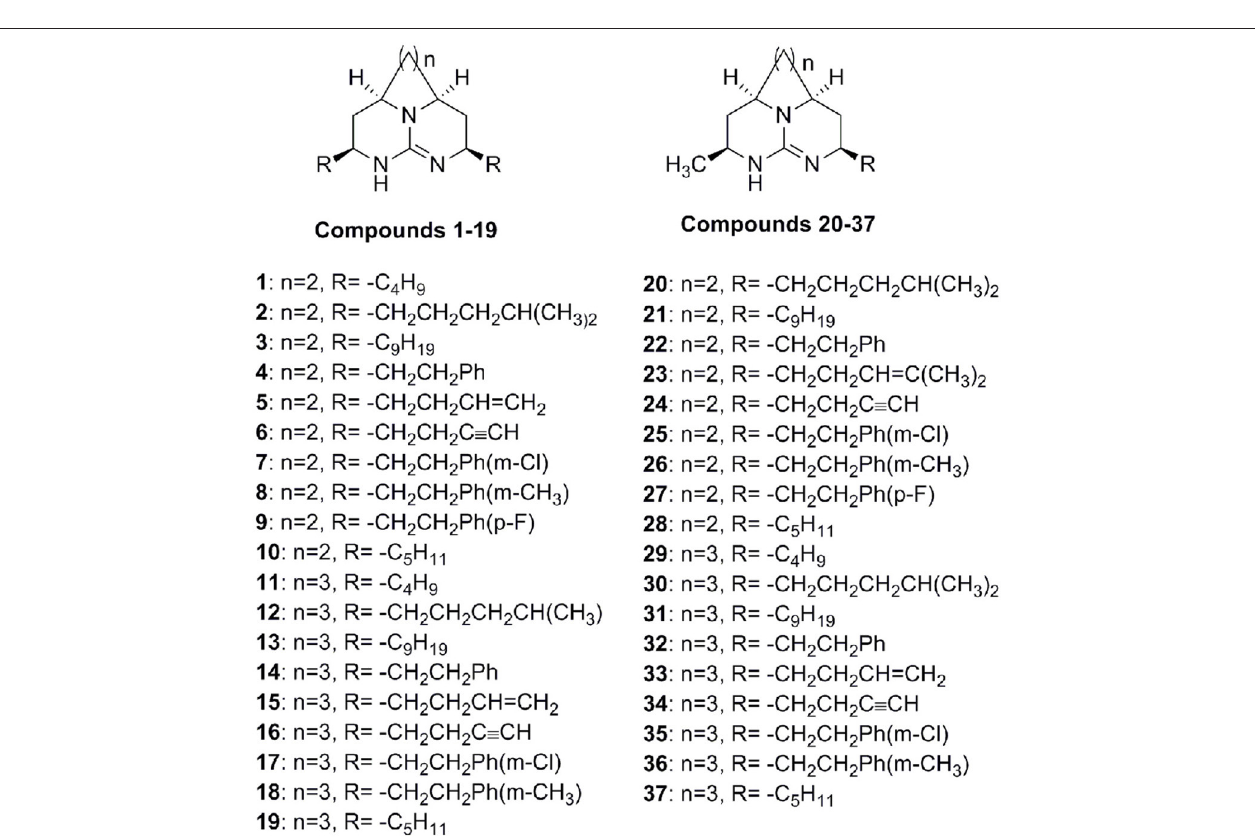
FIGURE 1 | Structures of tricyclic guanidine compounds used in this